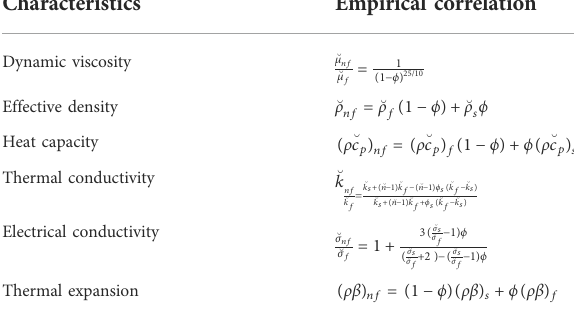
TABLE 1 Empirical correlations for fi rst-generation heat transfer fl